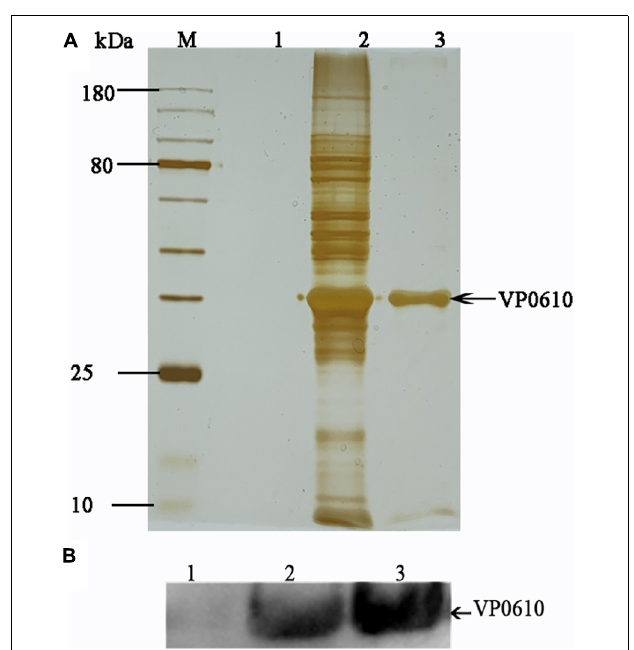
FIGURE 5 | Pull down. (A) Pull down experiment was carried out to find proteins interacting with His-VP0610. Lane 1: WT protein was incubated with Ni Sepharose absence of His-VP0610; Lane 2: WT protein was incubated with Ni Sepharose present of His-VP0610; Lane 3: Purified His-VP0610. (B) Western blot with anti-VP0610. Lane 1: WT protein was incubated with Ni Sepharose absence of His-VP0610; Lane 2: Purified His-VP0610; Lane 3: WT protein was incubated with Ni Sepharose present of